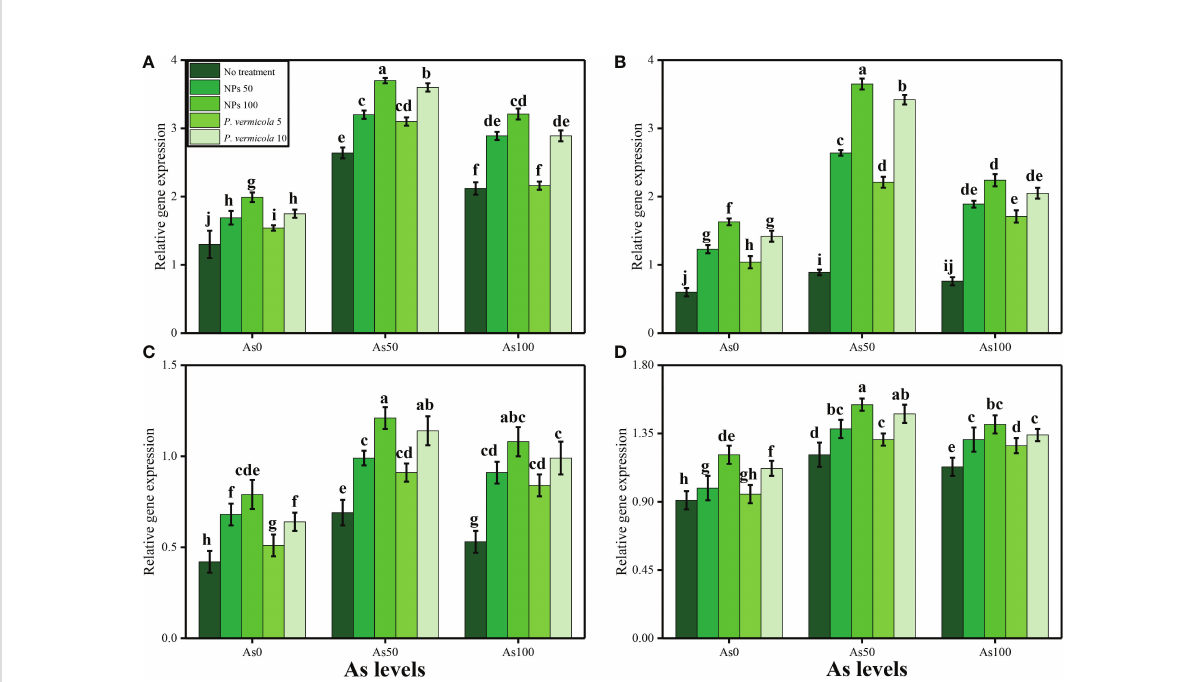
FIGURE 5 Effect of combined application of various levels of iron oxide nanoparticles (FeO-NPs) (i.e., 50 mg/l − 1 and 100 mg/l − 1 ) and plant growth- promoting bacteria ( Providencia vermicola ) (i.e., 5 ppm and 10 ppm) on iron superoxidase dismutase (Fe-SOD) (A) , peroxidase (POD) (B) , catalase (CAT) (C) , and ascorbate peroxidase (APX) (D) of Ajwain ( Trachyspermum ammi seedlings) grown under various stress levels of arsenic (i.e., 0 m M, 50 m M, and 100 m M). Values are demonstrated as means of four replicates along with standard deviation (SD; n = 4). Two-way ANOVA was performed and means differences were tested by Tukey ’ s highly signi fi cant difference post-hoc test ( p < 0.05). Different lowercase letters on the error bars indicate signi fi cant difference between the